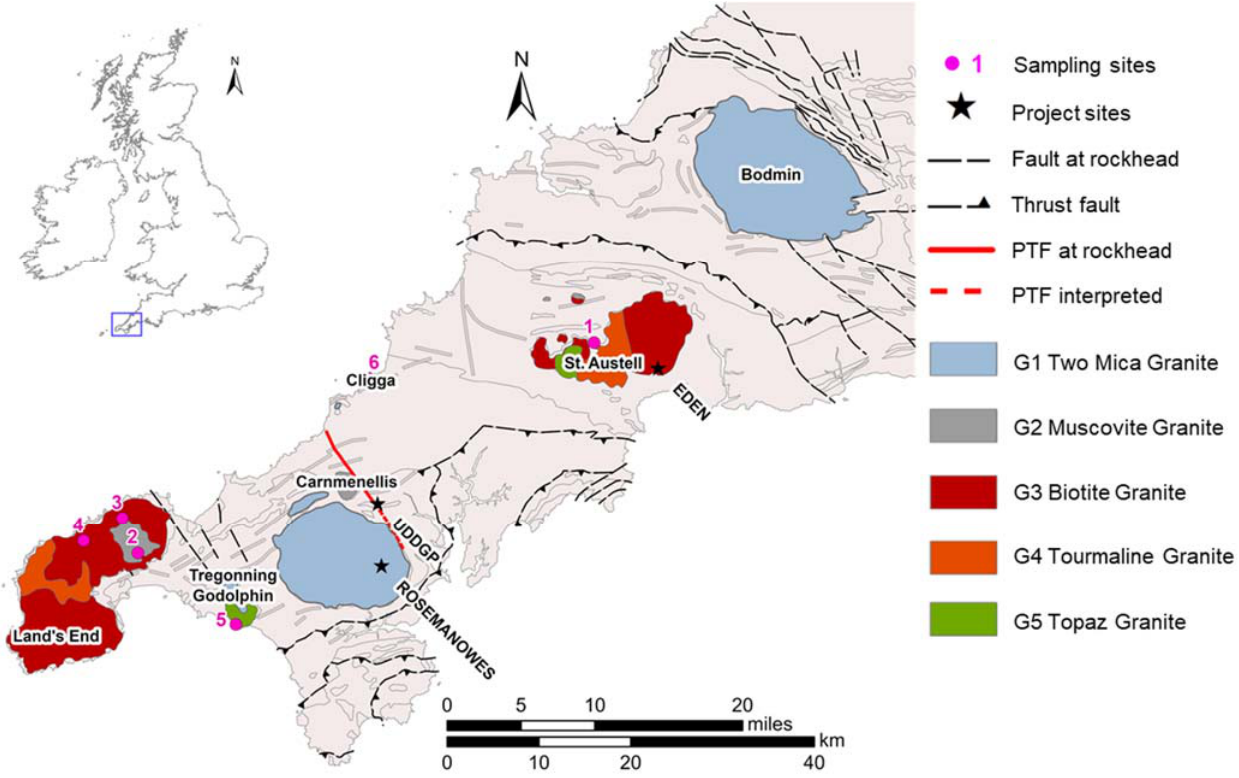
Figure 1. Simplified geological map of Cornwall, showing granite types after Simons et al. [5], sampling locations and relevant project locations; PTF simplified after Reinecker et al. [22]; meta sediments, dykes and non ‐ magmatic geological units in grey.